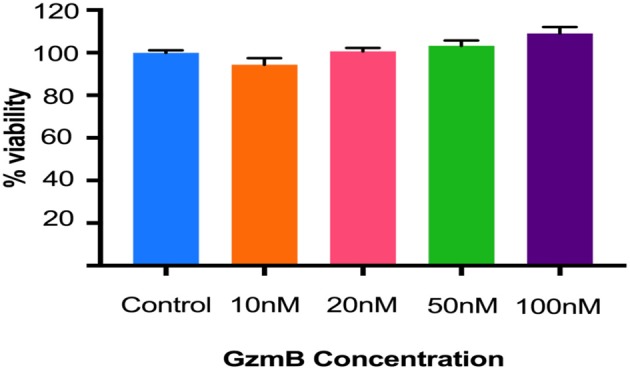
GzmB does not affect the viability of ARPE-19 cells. Cells were treated with exogenous GzmB (10, 20, 50, 100 nM) for 24 h and compared to controls (GzmB = 0 nM). No significant changes were observed in viability at any of the GzmB concentrations. Data were analyzed using one-way ANOVA test and Tukey's multiple comparisons post-hoc test (mean ± SEM, N = 5 per group).